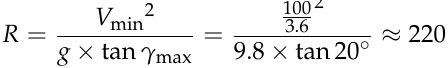
Figure 9. The mission point selection diagram, where the unnumbered point represents the take-off and landing point, and the marked points numbered 1 ∼ 9 represent the nine mission points selected in sequence.